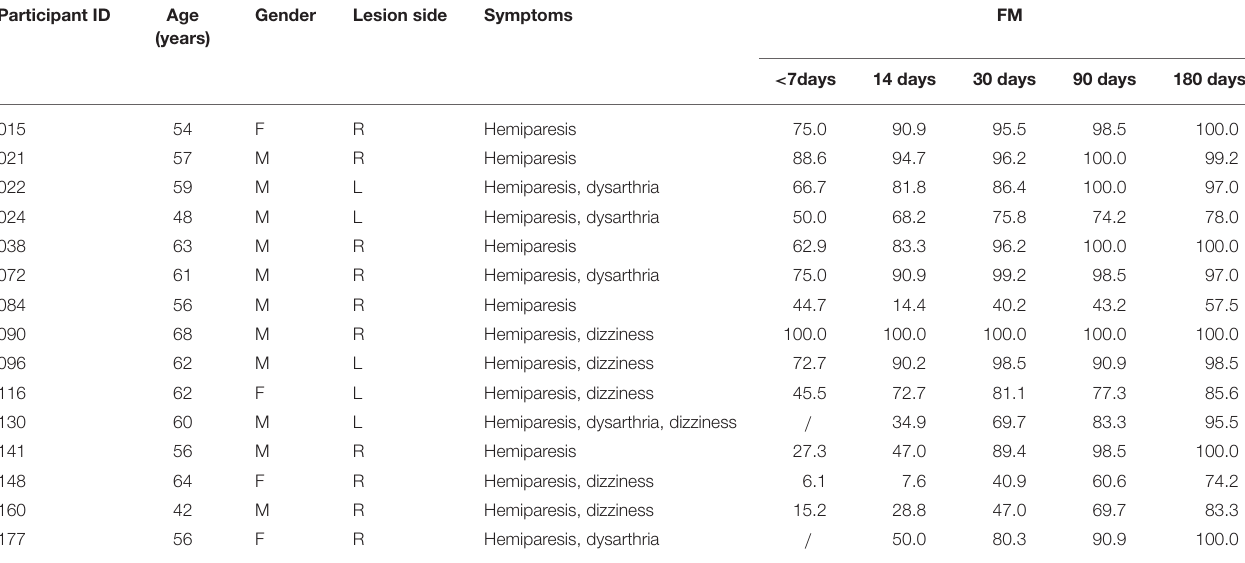
TABLE 1 | Demographics, clinical characteristics, and motor function scores of patients with pontine infarction. Participant